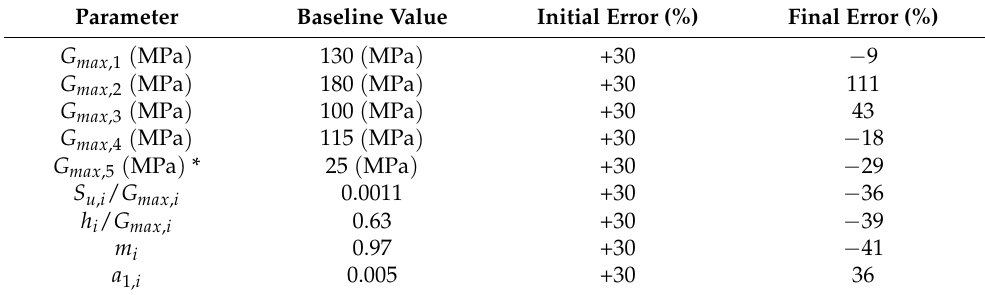
Table 5. The baseline values and initial and final errors of the parameters for the Lotung case study. Parameter Baseline Value Initial Error (%) Final Error (%)